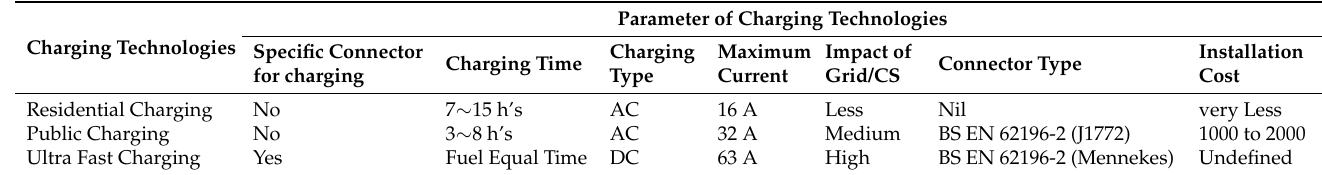
Table 4. Summary of Charging